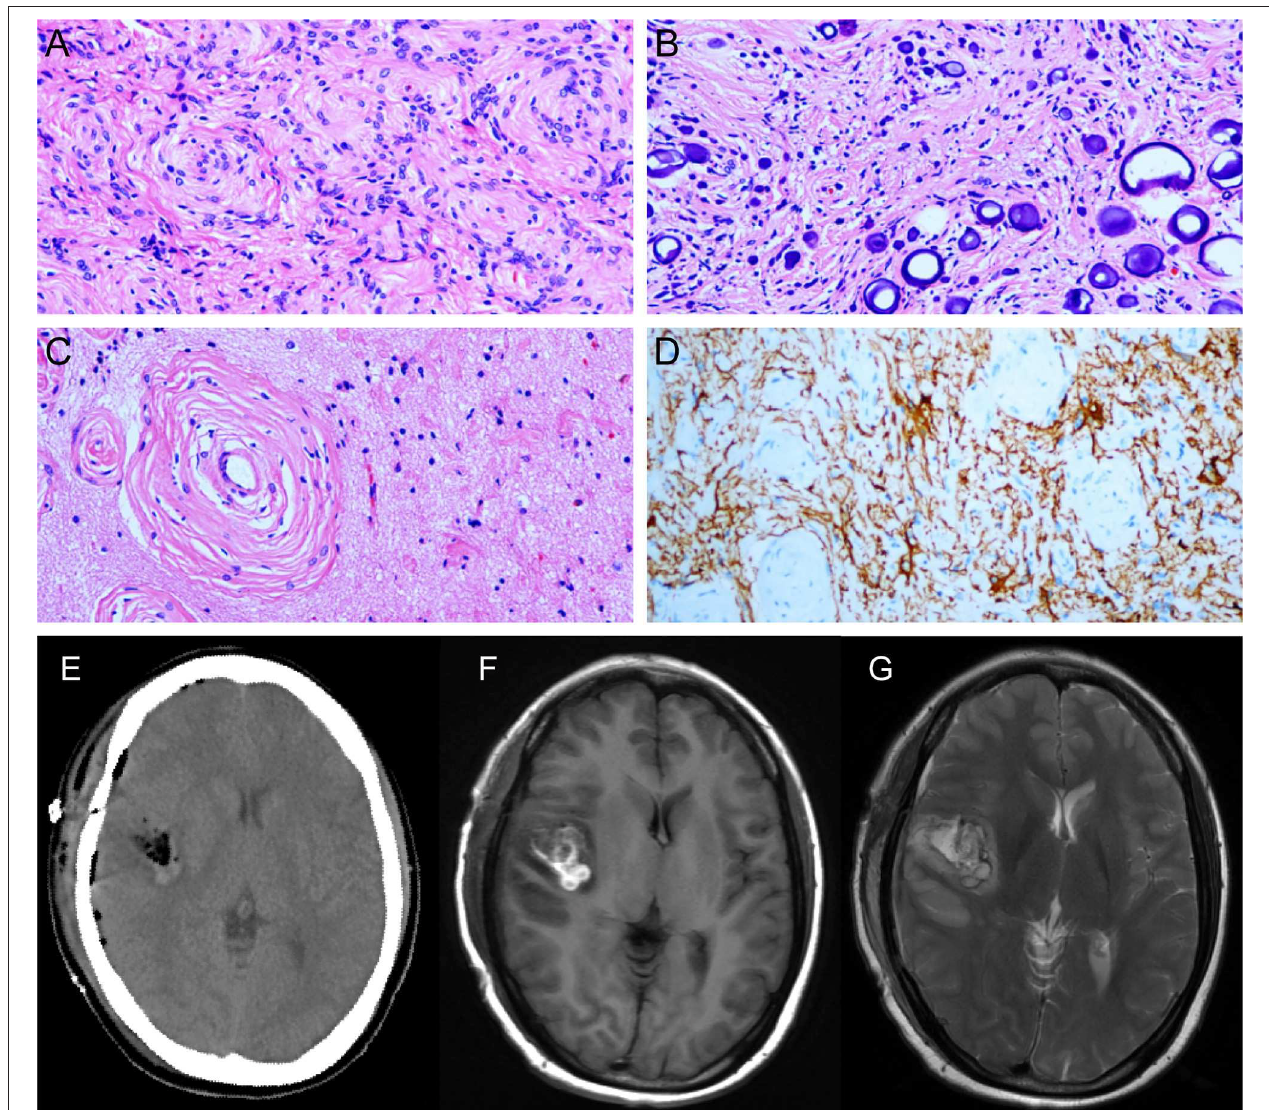
FIGURE 2 | (A) The tumor tissue arranged in swirl structure to form the meningeal corpuscle. (B) Psammoma bodies. (C) The meningeal corpuscles invade normal brain tissue. (D) GFAP staining show brain tissue ( + ) and meningeal corpuscles (-). Postoperative CT (E) and MRI (F,G) showed tumor gross total